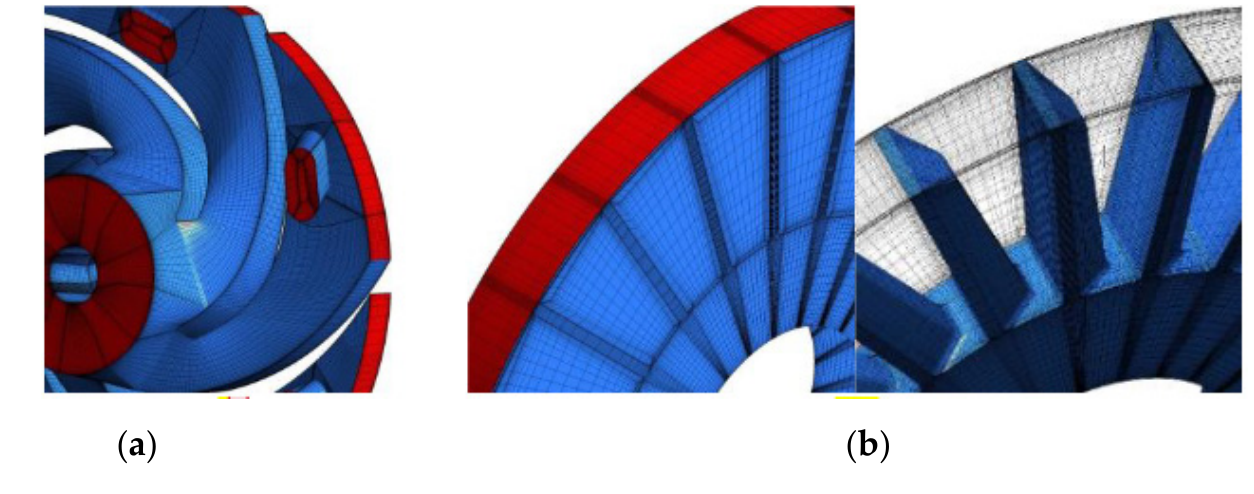
Figure 2. Partial mesh view of the flow domain: ( a ) centrifugal impeller; ( b ) side channel impeller.